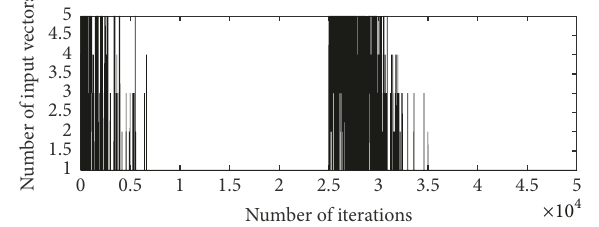
Figure 11: Zoomed view of the number of input vectors used in the proposed FXECAP-L algorithm when 𝐿 = 5 and 𝑏 = 8 in a variant single-channel